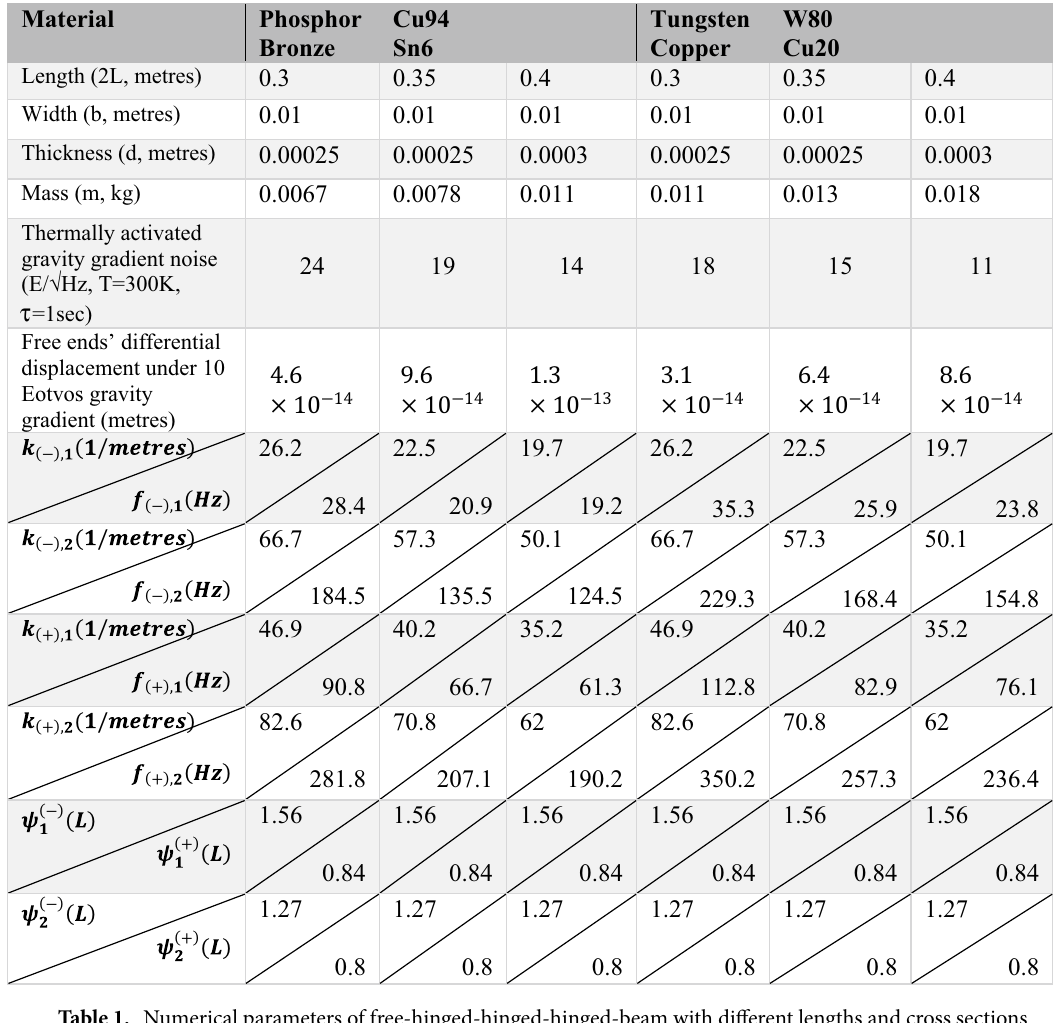
Table 1. Numerical parameters of free-hinged-hinged-hinged-beam with different lengths and cross sections for two different materials (Phosphor Bronze and Tungsten Copper alloys); Calculated the first two modal eigenvalues and mechanical resonant frequencies for both mirror-symmetric and symmetric eigenfunctions; calculated differential mechanical displacement of the beam’s free ends under 10 Eotvos gravity gradient and the thermally activated equivalent gravity gradient